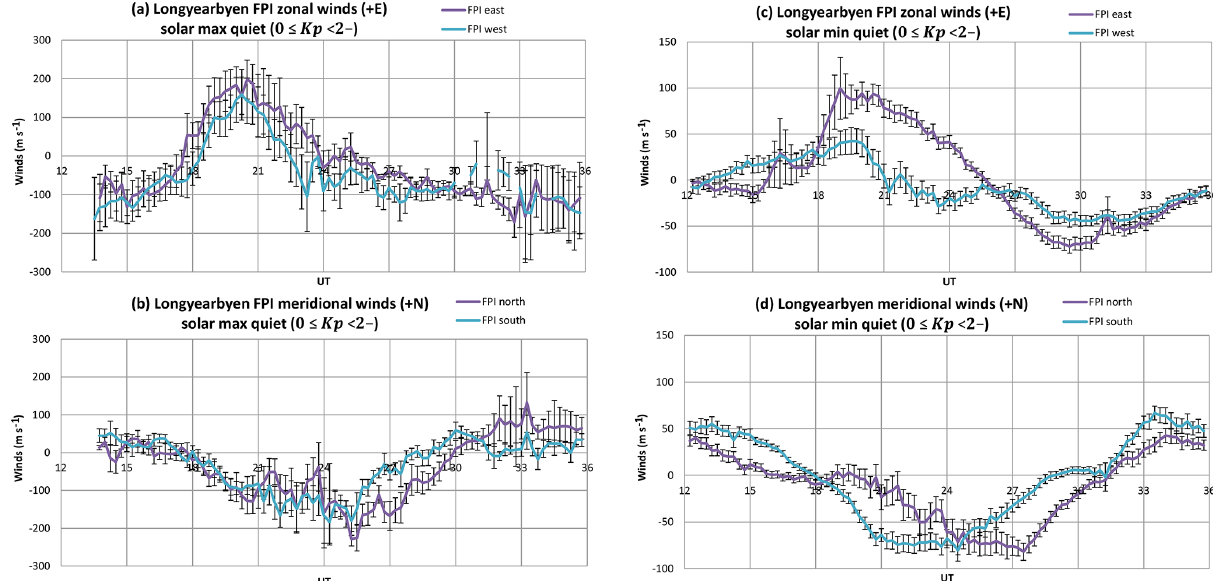
Figure 6. Panels (a) and (b) show the solar maximum (2001–2003) FPI winter average wind components at Longyearbyen for geomagneti- cally quiet conditions (0 ≤ Kp<2 − ). Zonal (a) and meridional (b) average winds and the standard errors of the mean are plotted. North and east are shown using purple lines in (b) and (a) respectively, whereas south and west are shown using light blue lines in (b) and (a) respec- tively. Panels (c) and (d) show the solar minimum (2005–2007) FPI winter average wind components at Longyearbyen for geomagnetically quiet conditions (0 ≤ Kp<2 − ). Zonal (c) and meridional (d) average winds and the standard errors of the mean are plotted. North and east are shown using purple lines in (d) and (b) respectively, whereas south and west are shown using light blue lines (d) and (b) respectively.